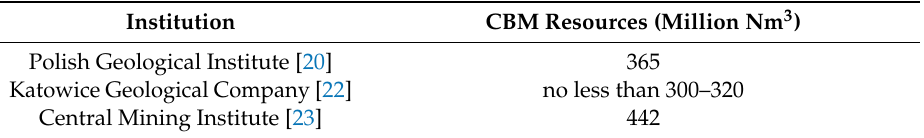
Table 1. Coal bed methane (CBM) resources in the Upper Silesian Coal